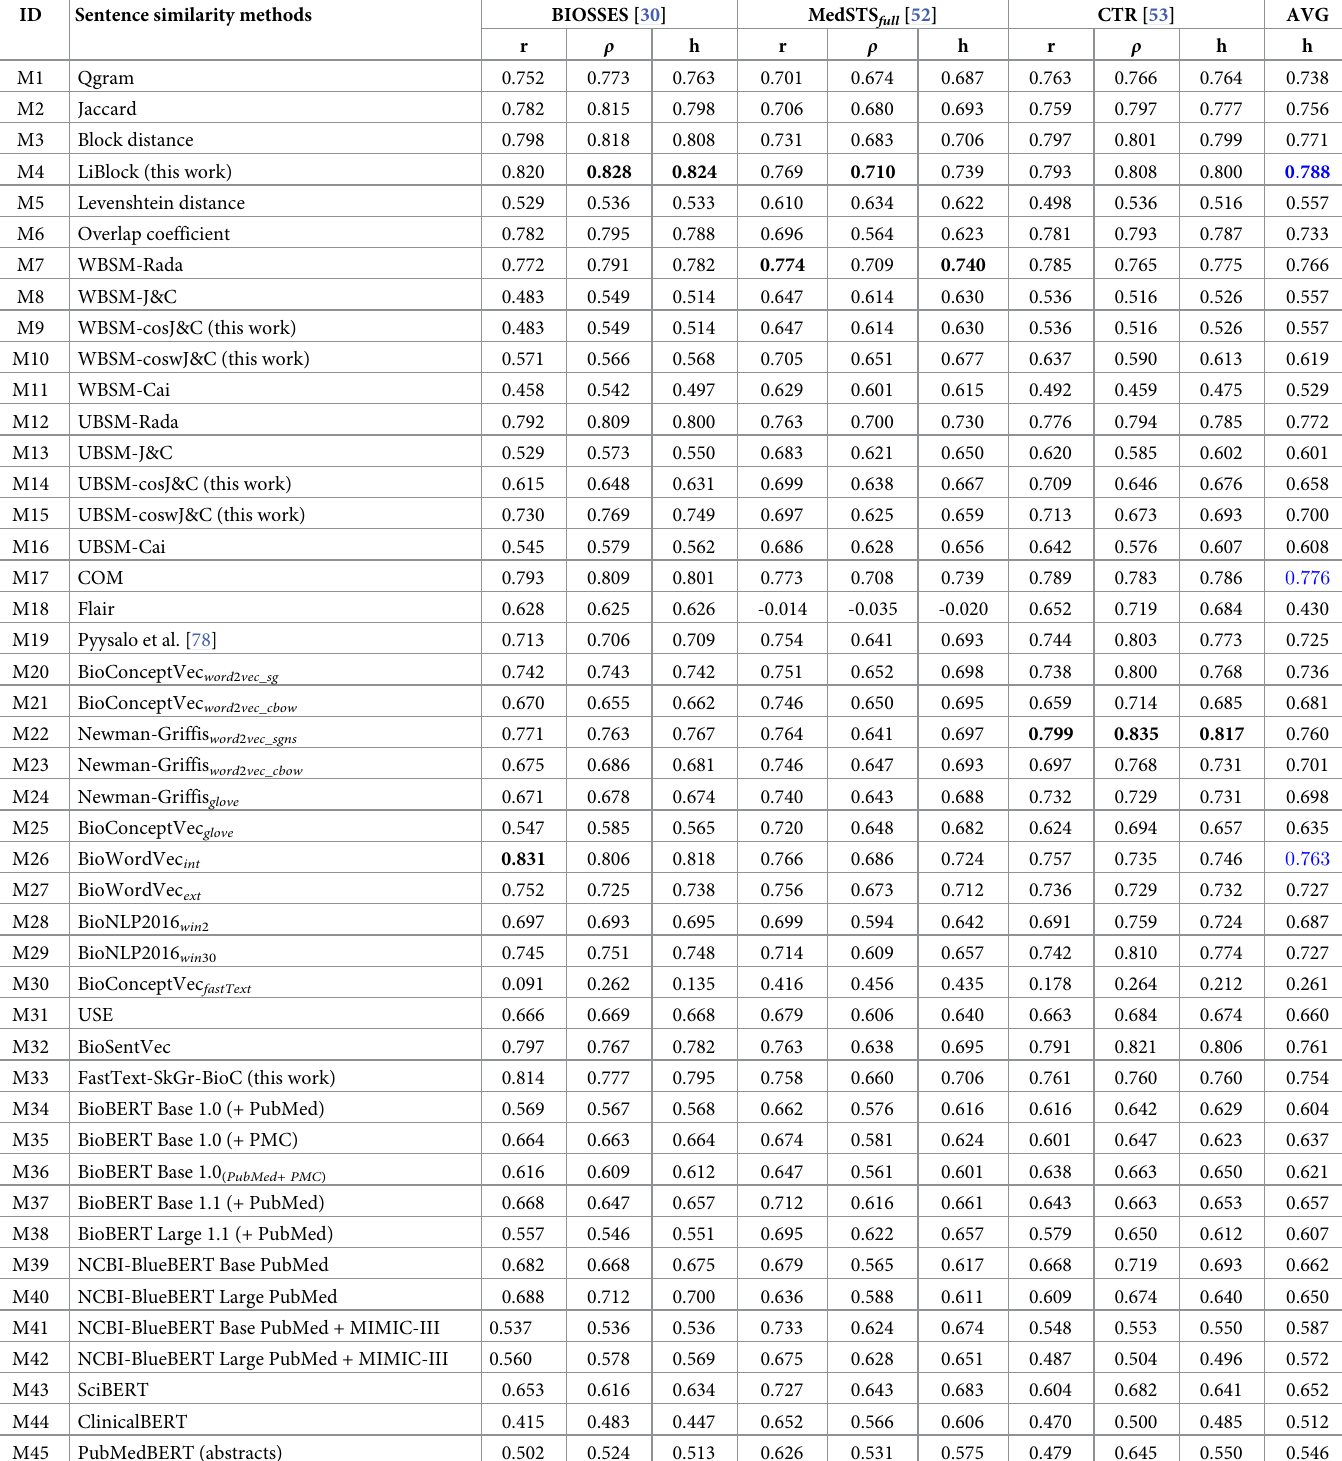
Table 8. Pearson (r), Spearman ( ρ ), harmonic ( h ), and harmonic average (AVG) scores obtained by each sentence similarity method evaluated herein in the three biomedical sentence similarity benchmarks arranged by families. All reported values were obtained using the best pre-processing configurations detailed in Table 7. The results in bold show the best scores whilst results in blue show the best average harmonic score for each